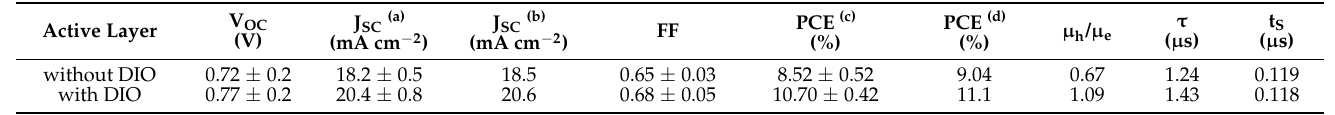
Table 1. Summary of the photovoltaic parameters of the PM6:BTP − eC9 − based ssNP solar cells with and without DIO.